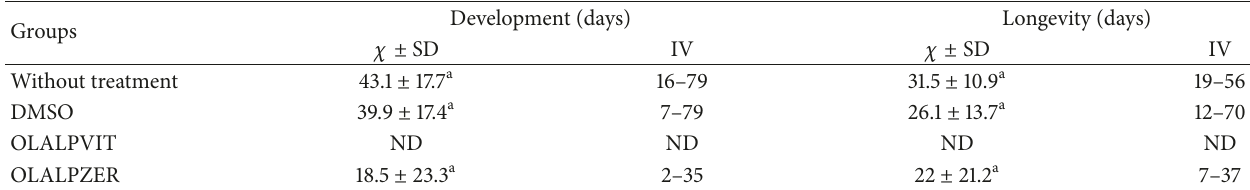
Table 3: Development of R. nasutus (fifth-instar nymphs to adult) and longevity of adults treated with OLALPVIT and OLALPZER at 125 𝜇 g/ 𝜇 L.